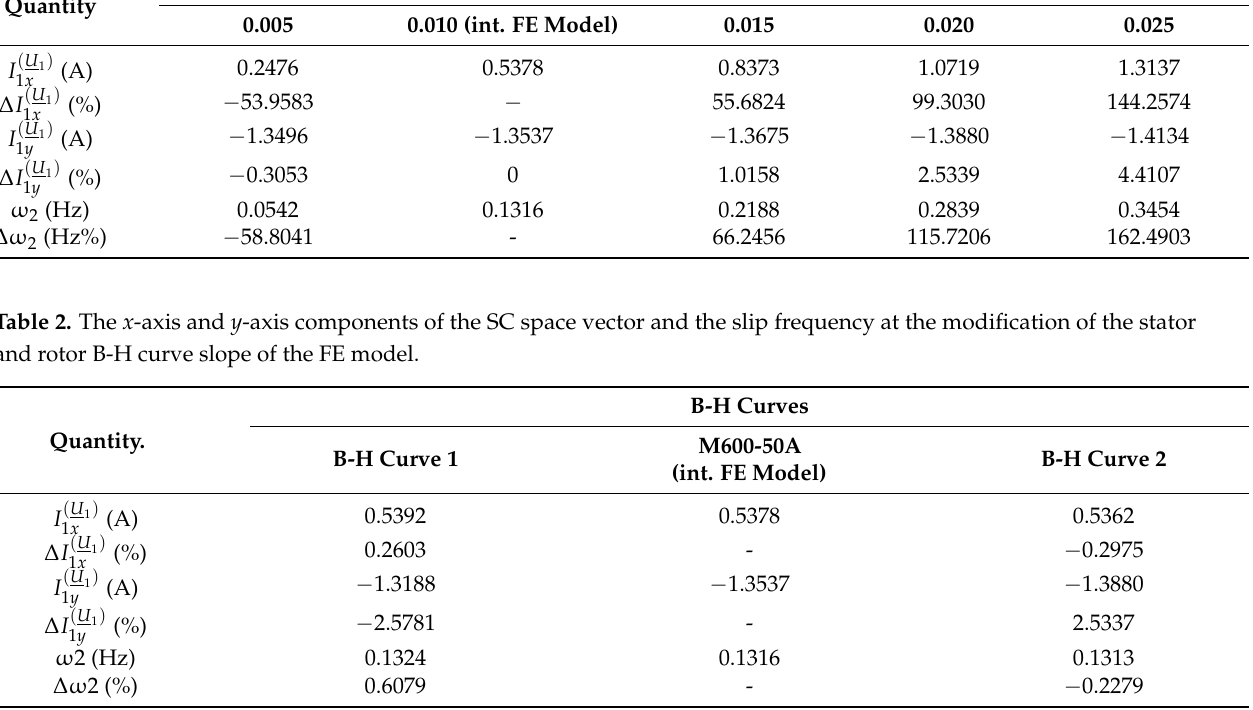
Table 1. The x -axis and y -axis components of the SC space vector and the slip frequency at the modification of the FE-model damping coefficient.